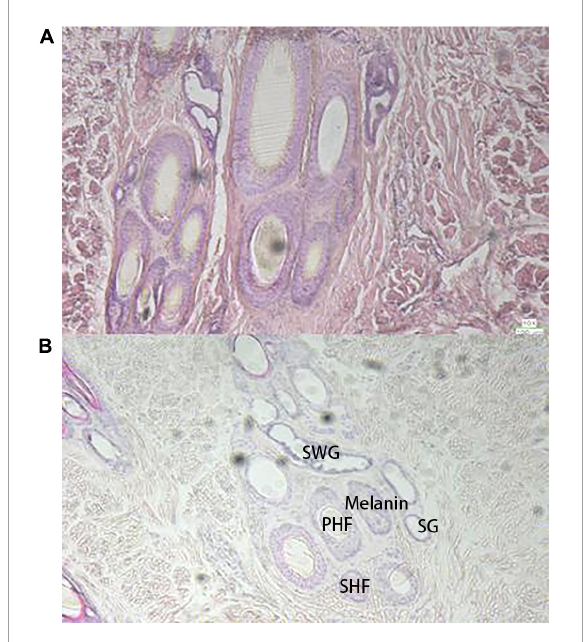
FIGURE1 Observation of skin tissue with H and E staining sections (10 × ), (A) the black hair base; (B) the white hair base.